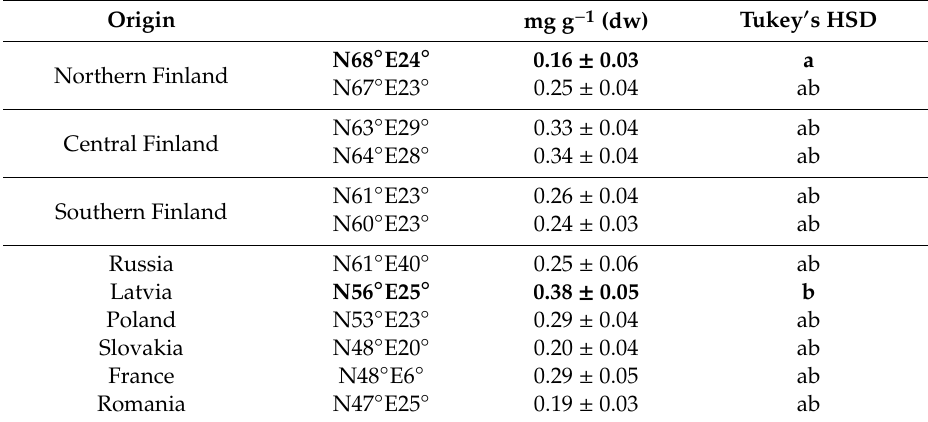
Table 2. 1,6-dehydropinidine concentration in mature needles of P. abies from provenance experiment in which trees of different origins were grown for 35 years in the same place (N°61, E°29).